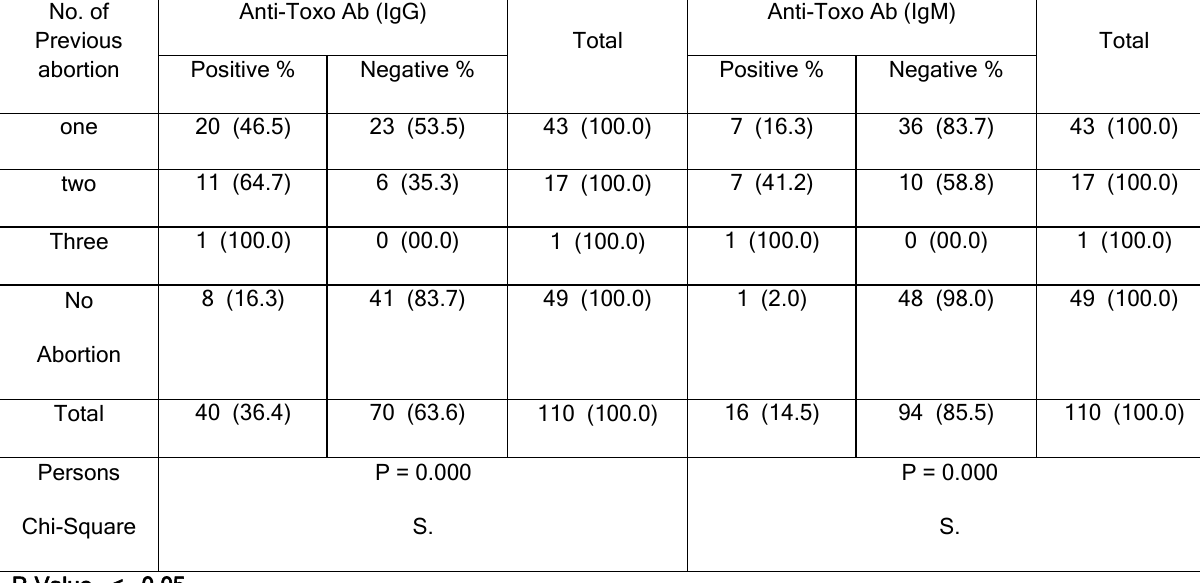
Table (5): Association between the seropositivity rates by ELISA (IgG, IgM) and the number of previous abortion. No. of